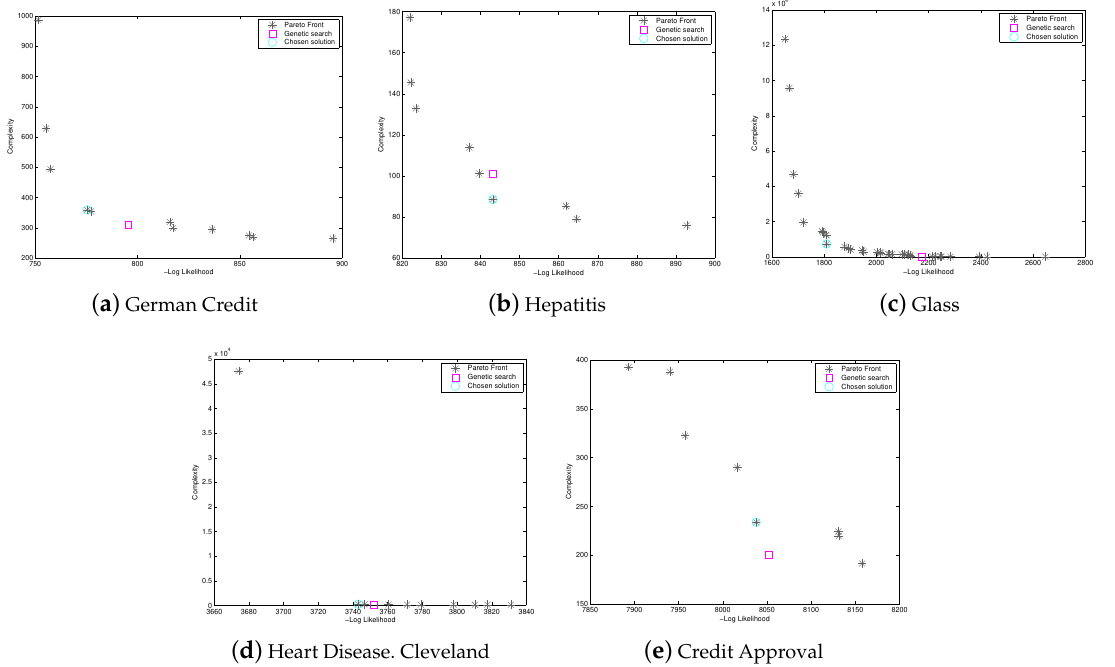
Figure 7. Accumulated Pareto front of the UCI repository databases. Gray stars—the accumulated front obtained by ten runs of NS2BN. Pink square—the GABN solution and green circle—the chosen solution from the NS2BN Pareto